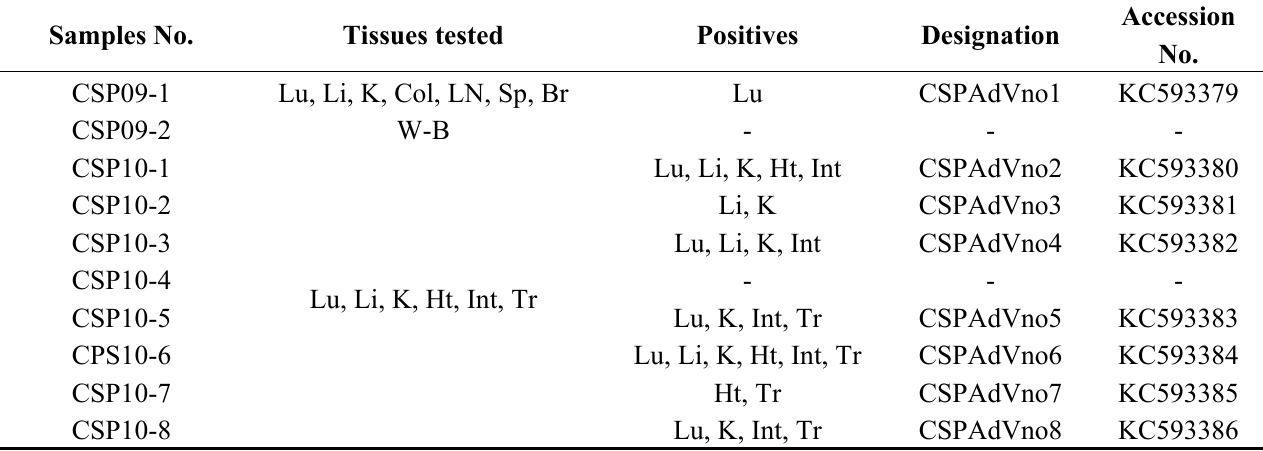
Table 1. Detection of Chinstrap penguin adenovirus in various tissues by PCR, with GenBank accession numbers.